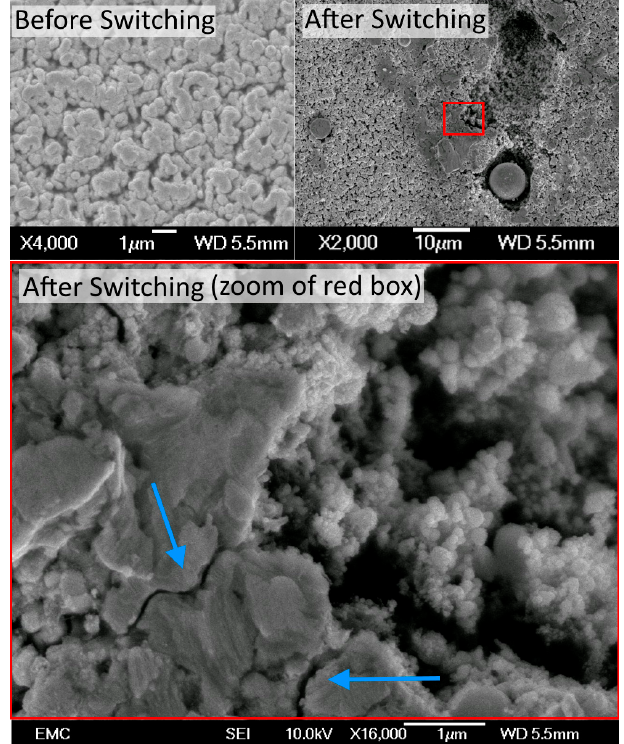
Figure 9. Electron micrographs of the Au/MWCNT surface before switching (top left) and after hot switching 1,000,000 cycles at 4 V 20 mA (top right). The main image (bottom) is magnified to show cracks in the surface (blue arrows) next to a region where Au is being worn away.